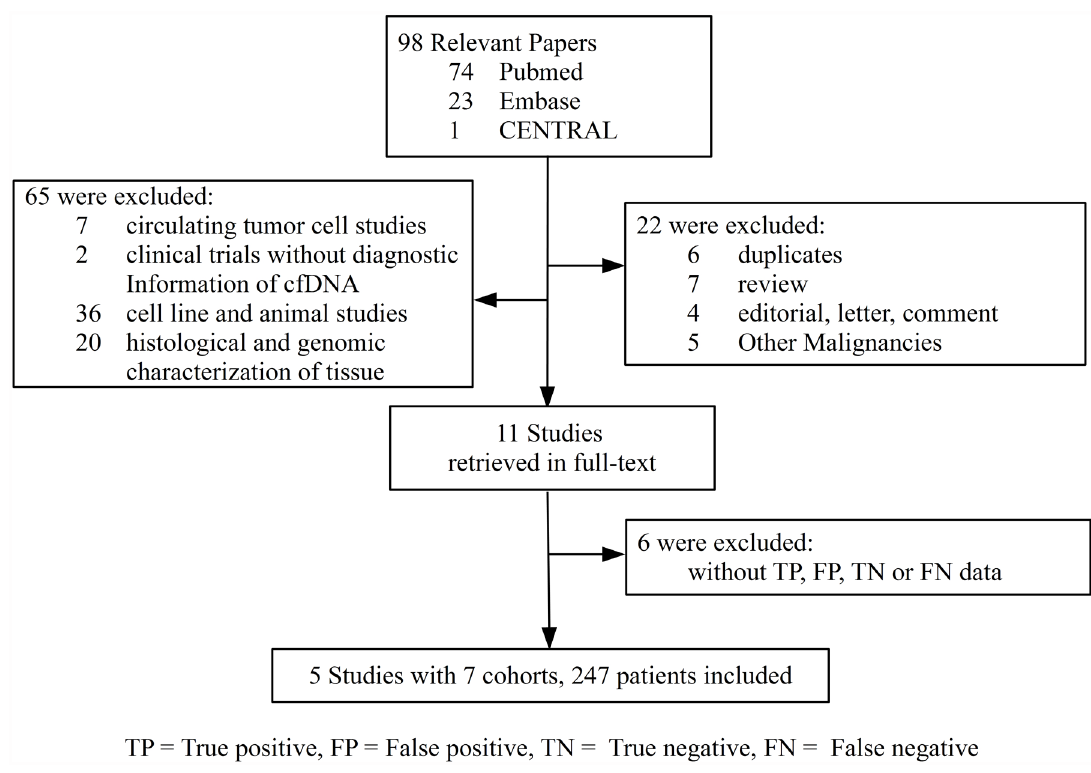
Fig 1. Flowchart of articles reviewed and included in